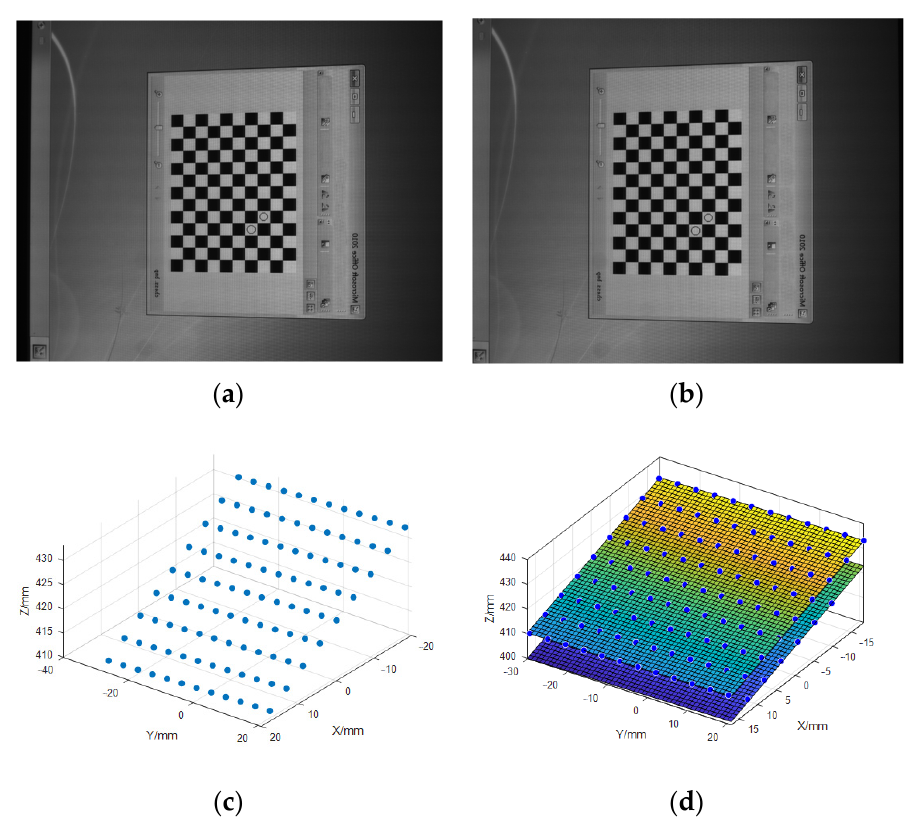
Figure 9. Restoration of plane mirror feature points at position 5. ( a ) Mirrored checkerboard image before placing the standard gauge block. ( b ) Mirrored checkerboard image after placing the standard gauge block. ( c ) Mirror feature points at position STZ. ( d ) Plane fitting of two mirror feature points. The distance between the two planes is 8.68 mm.